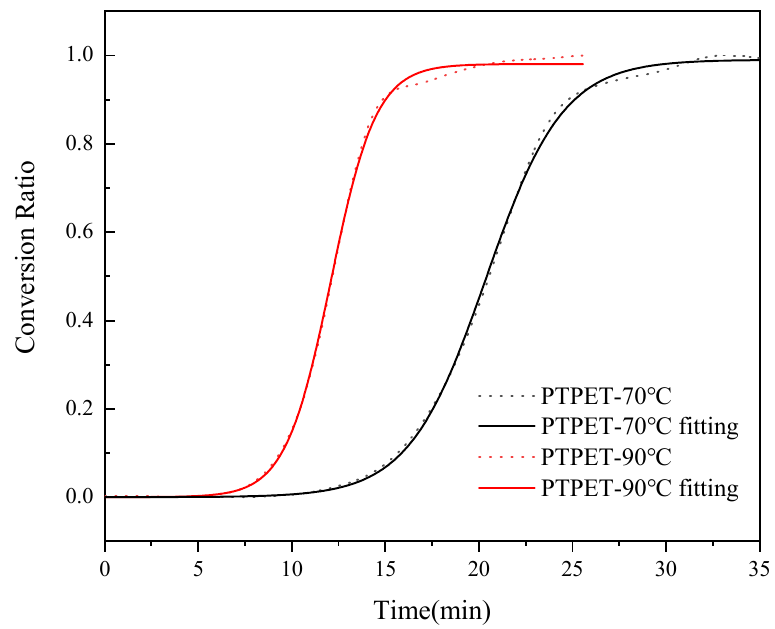
Figure 4. The conversion ratio of ATPET and GAP reactions versus time and the fitting curve.